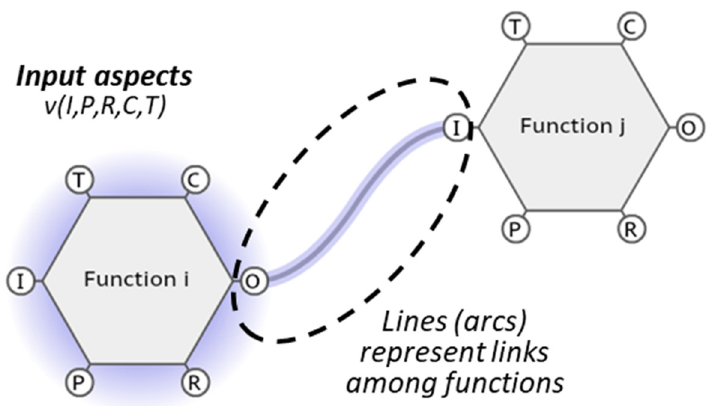
Figure 1. Example of the graphical language of Functional Resonance Analysis Method (FRAM) model.